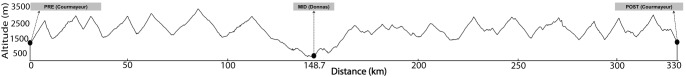
Altitude profile of the entire run with the three session test locations and the distance scale in km.